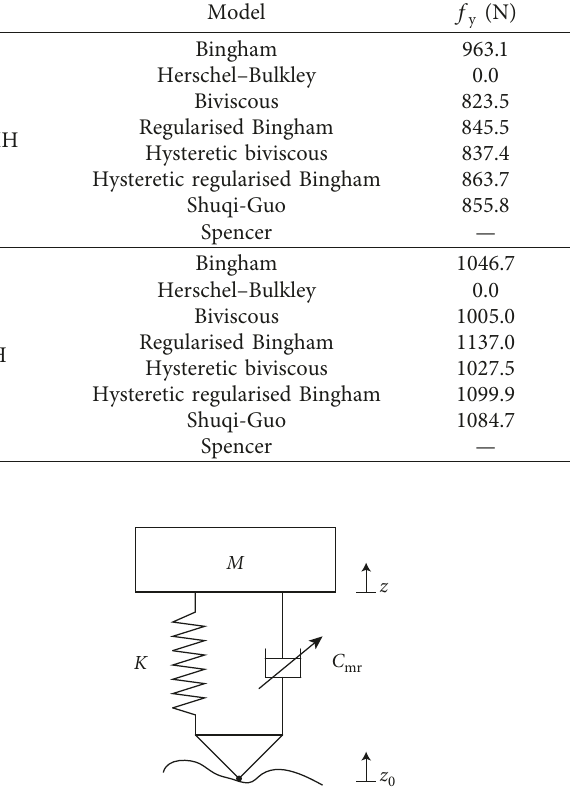
Figure 16: The quarter-car suspension